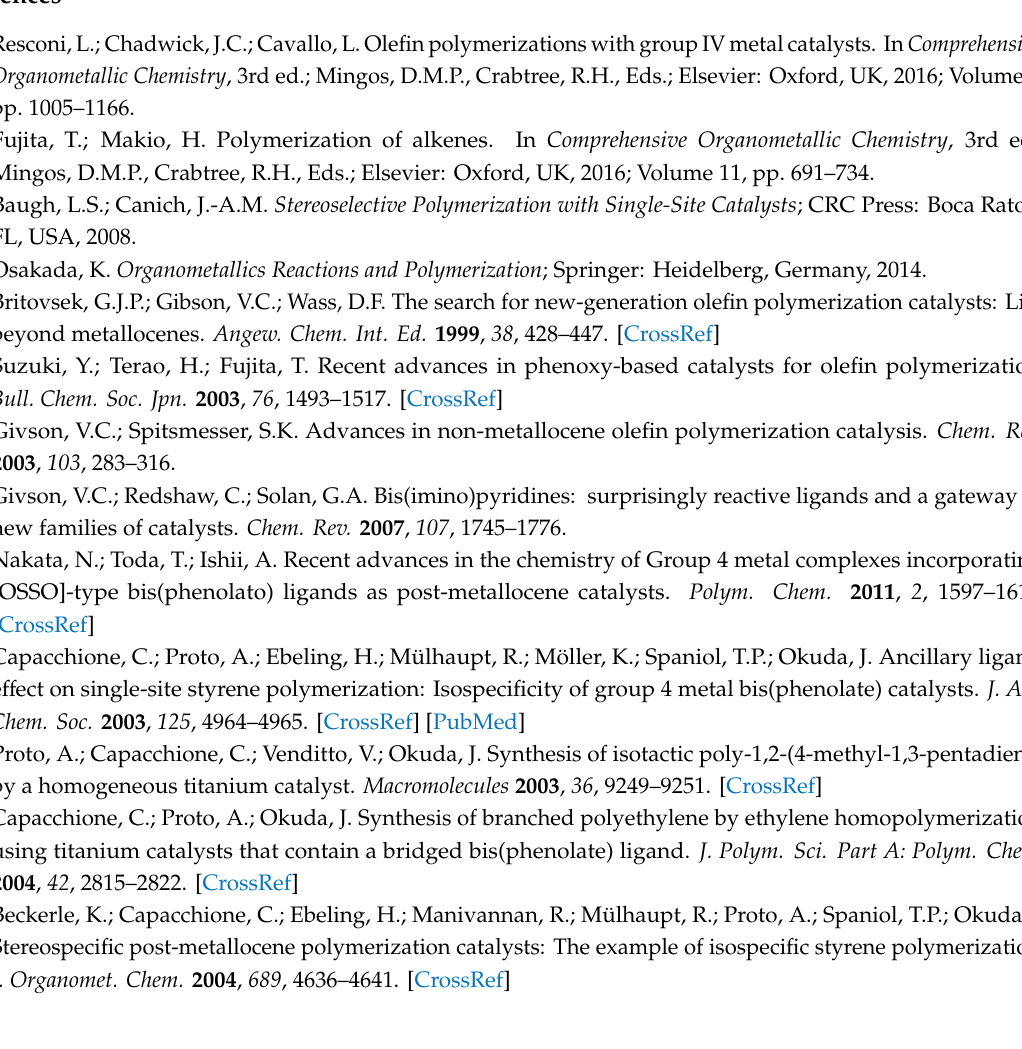
Figure S1: 1 H NMR spectrum of dibenzyl zirconium(IV) complex 4 , Figure S2: 1 H NMR spectrum of oligo(1-hexene) obtained by the 4 / dMMAO system at 25 ◦ C (Table 1, Run 4), Figure S3: 13 C{ 1 H} NMR spectrum of oligo(1-hexene) obtained by the 4 / dMMAO system at 25 ◦ C (Table 1, Run 4), Figure S4: 13 C{ 1 H} NMR spectrum of isotactic polystyrene obtained by the 4 / dMAO system at 70 ◦ C (Table 2, Run